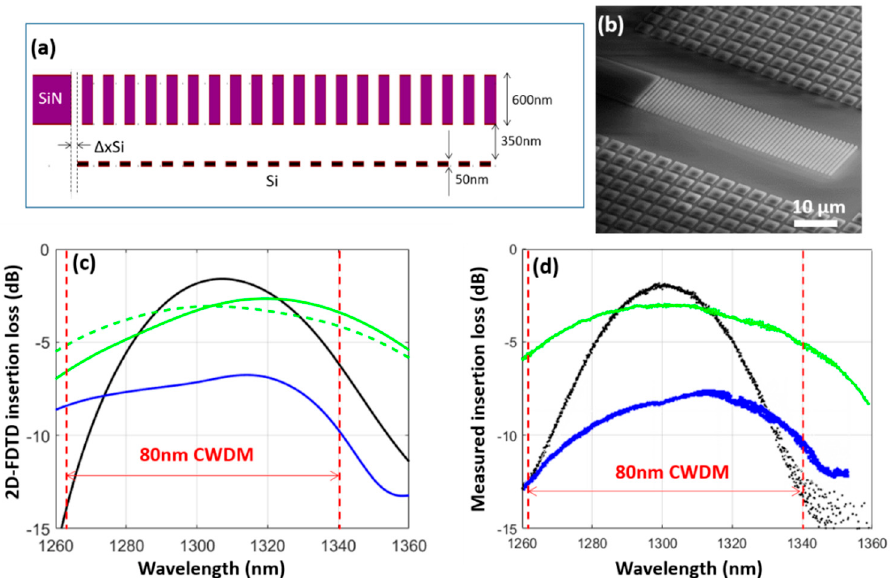
Figure 4. ( a ) Schematic side view of the SiN/Si grating; ( b ) SEM image of the hybrid SiN-Si grating coupler; ( c ) Simulated insertion loss of the apodised Si design (black line), the uniform SiN design (blue line), the best-performing simulated SiSiN design (dashed green line), and the best-performing fabricated SiSiN design (solid green line). ( d ) Same as ( c ), but for the measured designs.